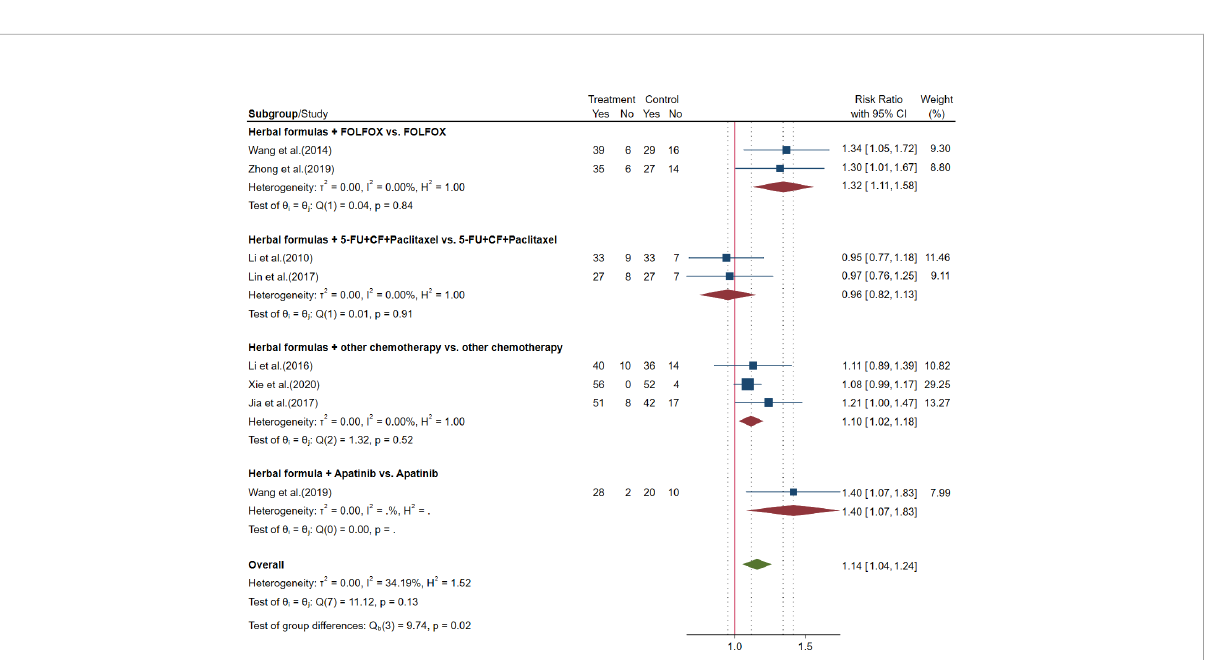
FIGURE 7 Forest plot of disease control rate (DCR) in advanced gastric cancer